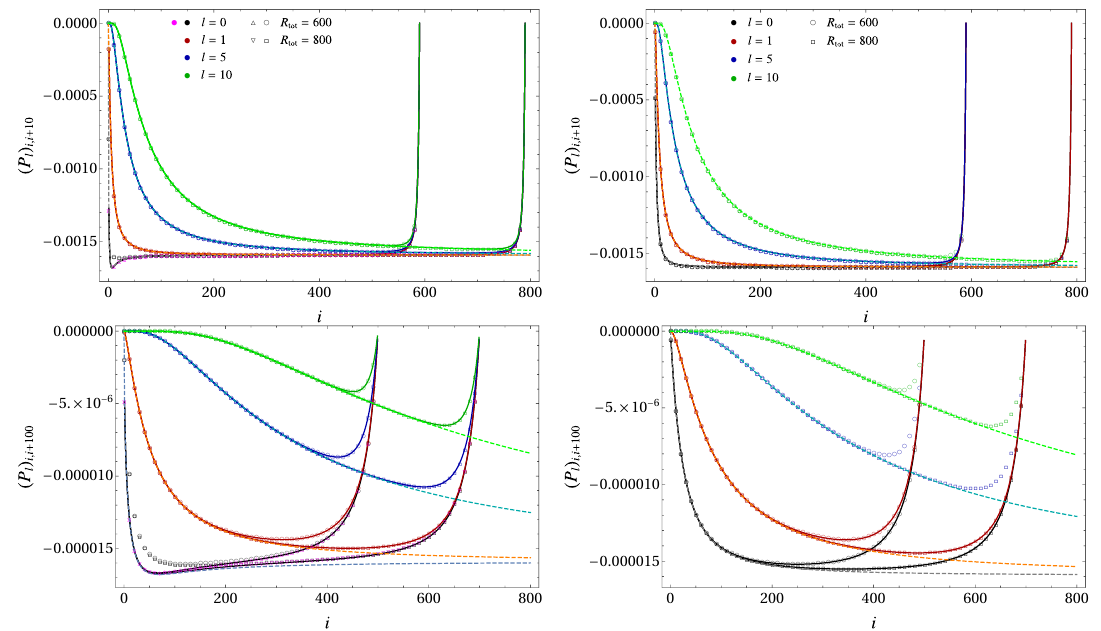
Figure 13. Correlators (2.15) in the massless regime: P i,i +10 (top panels) and P i,i +100 (bottom panels) for d = 2 (left panels) and d = 3 (right panels) evaluated from (2.14) with ω = 0 and for systems whose total size is given by R ∈ { 600 , 800 } . The dashed lines correspond to (A.9) and tot the solid ones to (A.12) with m = 0 . The magenta data points are obtained from (A.16) with ω = 0